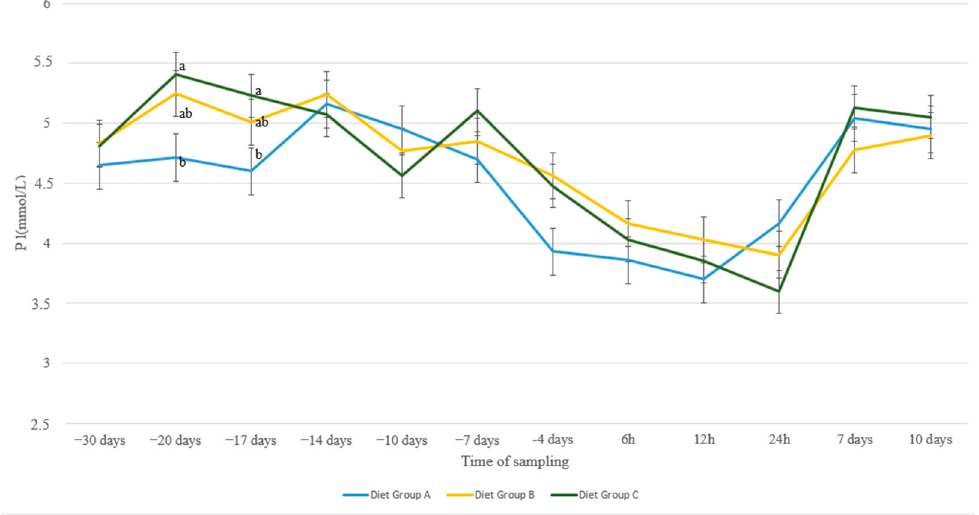
Figure 5. P levels (mmol/L) in blood serum of sheep in group A (control group, n = 27), group B (supplemented diet with beet pulp, n = 31), and group C (supplemented diet with beet pulp and ammonium chloride, n = 29) during the peri-parturient period. a,b Different letters denote significant differences between groups within evaluation time ( p < 0.05).